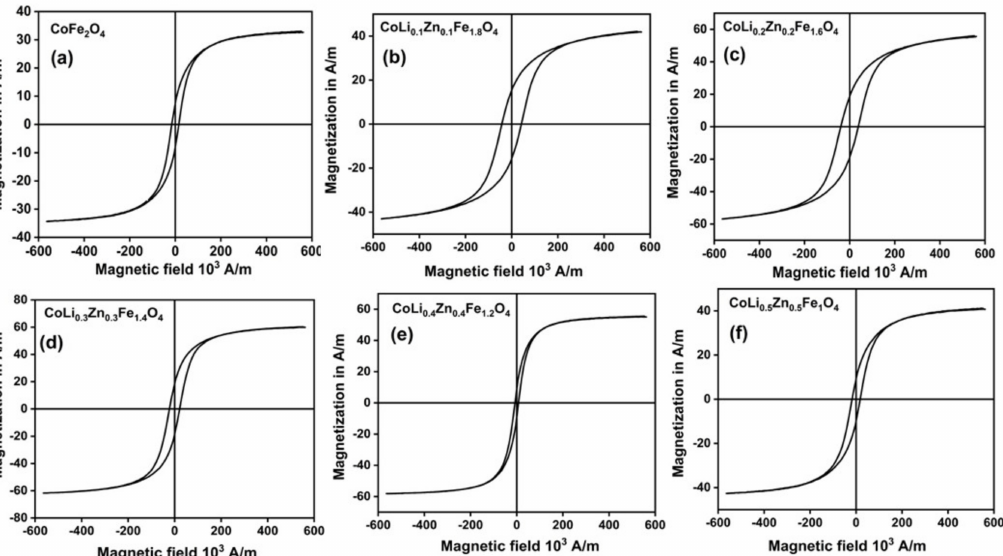
Figure 4. ( a – f ). Hysteresis loop for pure cobalt ferrite (x = 0) and doped CoLi x Zn x Fe 2 − 2x O 4 (x = 0.1–0.5) at room temperature.